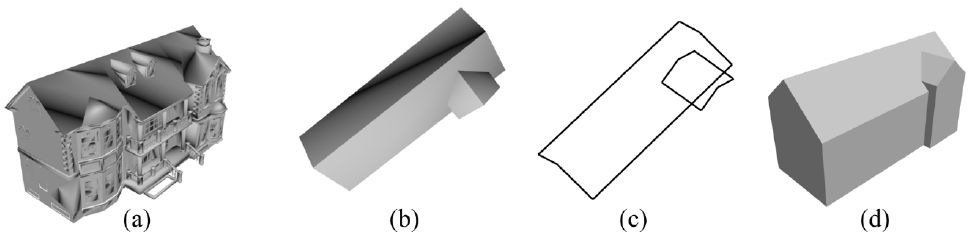
Figure 2. Simplification procedure of a 3D building with four sloped roofs: ( a ) the original 3D building; ( b ) the simplified roofs; ( c ) the extracted roof contours; and ( d ) the reconstructed watertight 3D building